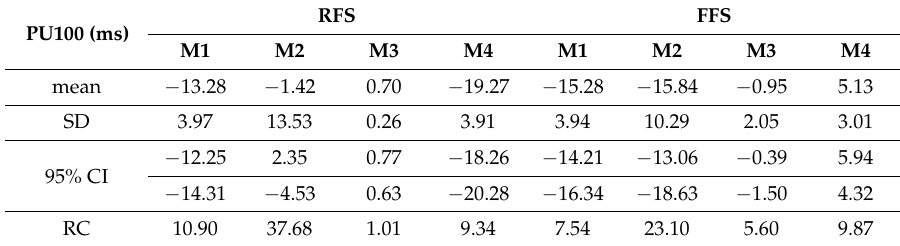
Table 2. Accuracy (mean) ± precision (standard deviation: SD), 95% confidence intervals (95% CI), and repeatability coefficient (RC) of foot strike detection methods (M1 to M4) for PUMA Speed 100 (PU100) and rearfoot (RFS) and forefoot strike (FFS) pattern.